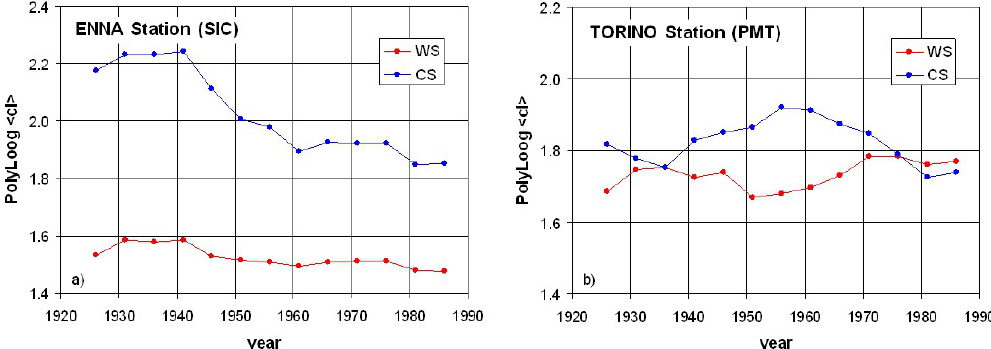
Figure 7. Time-series of expected cluster size estimated by polylog-series distribution, for both season and for two sites: (a) for Enna station (SIC); (b) for Torino station